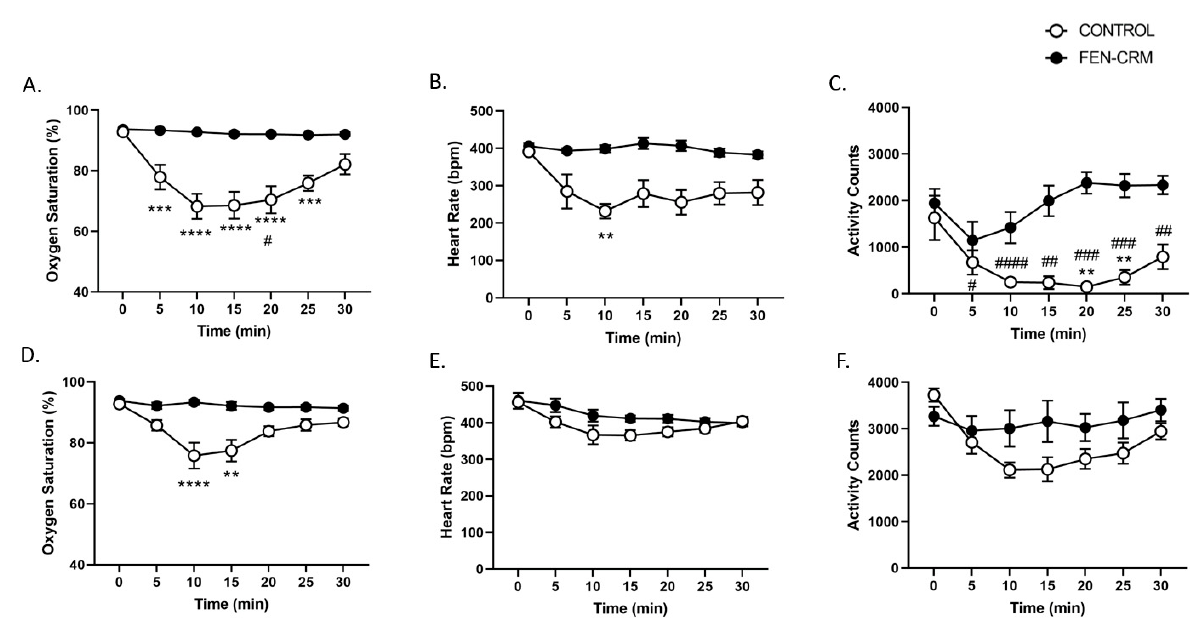
Figure 5. Vaccine efficacy against FEN-induced physiological effects in male and female Sprague Dawley rats. Sprague Dawley rats (male, CONTROL, N = 6, FEN-CRM, N = 8, ( A – C ); female, CON- TROL, N = 9, FEN-CRM, N = 6, ( D – F )). Groups were vaccinated with PBS or FEN-CRM+dmLT (day 0, 3 and 6 weeks, IM) and at approximately 10 weeks post initial vaccination rats were administered 0.1 mg/kg FEN (SC) and oxygen saturation (%), heart rate (beats per minute, bpm), and activity (counts) were measured using a pulse oximetry system. FEN significantly decreased all measures in unvaccinated male rats and these effects were attenuated by the vaccine. FEN significantly decreased oxygen saturation in unvaccinated female rats that was reversed by vaccination. CONTROL vs. FEN-CRM male and female groups: ** p < 0.01, *** p < 0.001,**** p < 0.0001; CONTROL male vs. CONTROL female groups: # p < 0.05, ## p < 0.01, ### p < 0.001, #### p < 0.0001 .